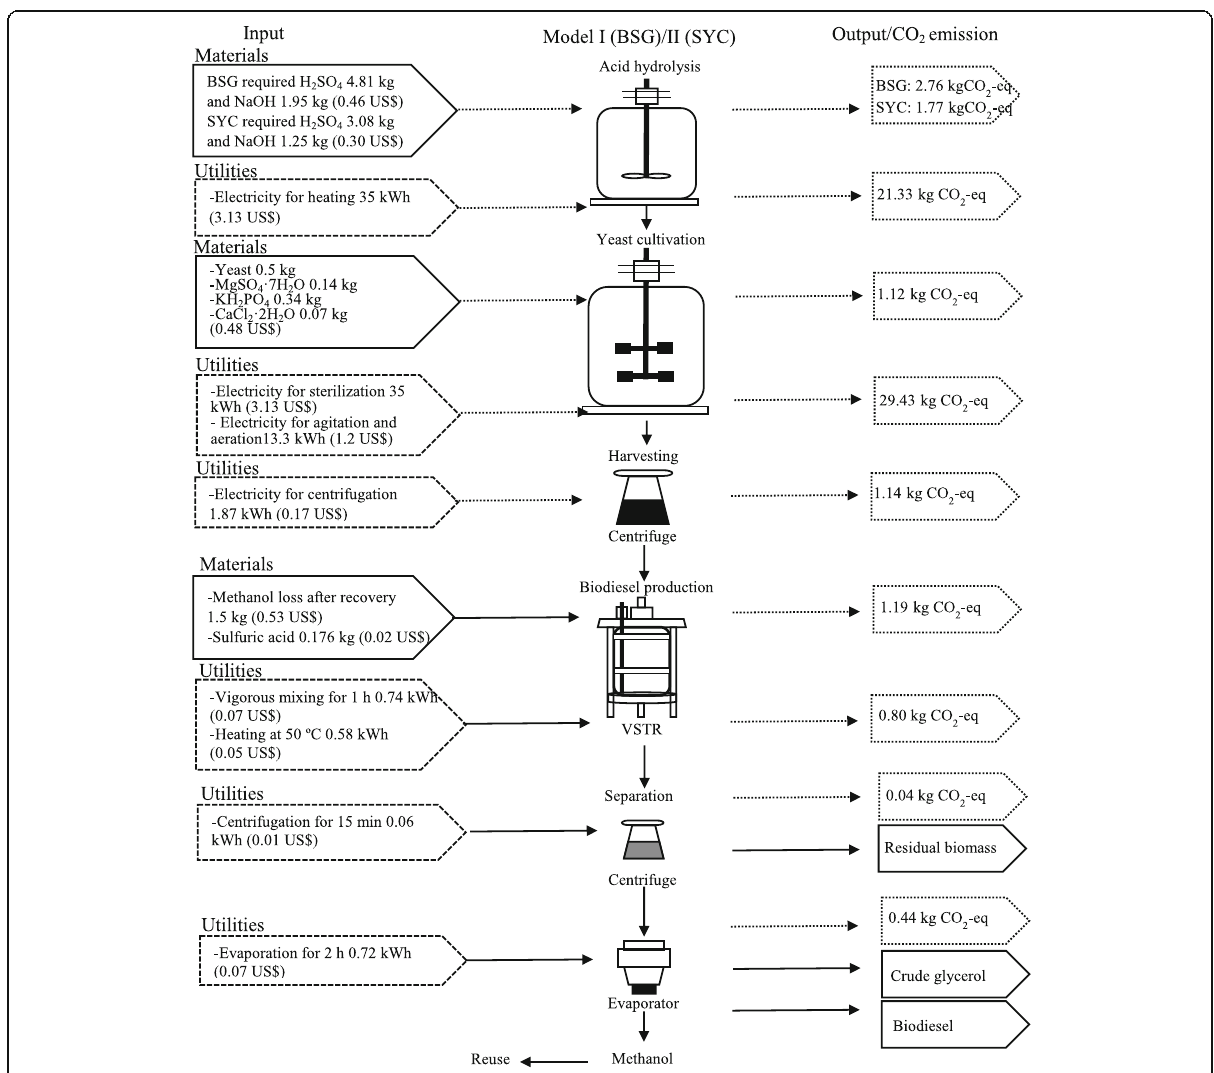
Fig. 2 Process flow for bioconversion of brewer ’ s spent grain and spent yeast cell into lipids by selected oleaginous yeasts in 1 m 3 reactor scale and subsequent biodiesel production in 30 L